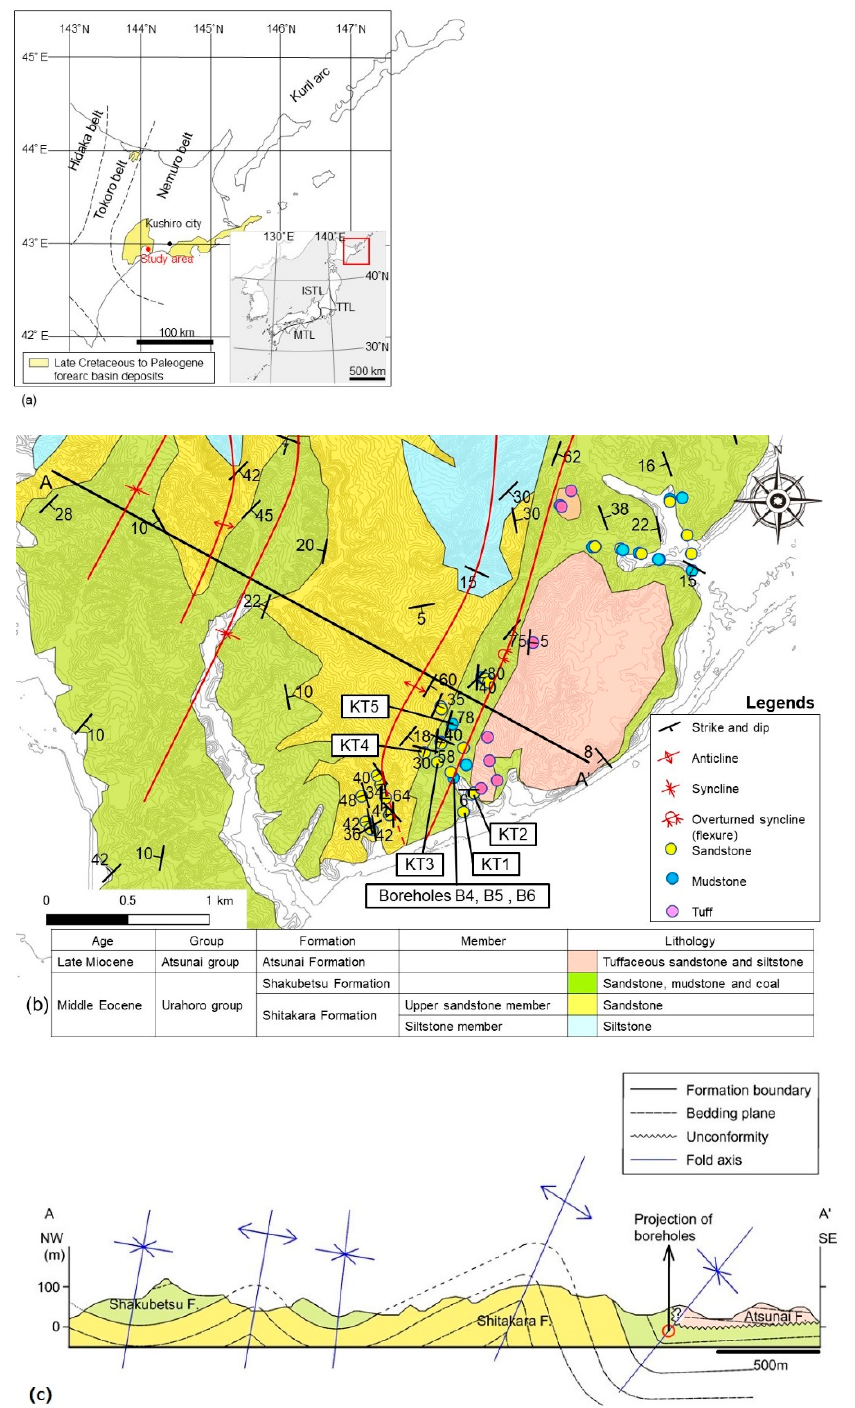
Figure 1. ( a ) Index map showing the Late Cretaceous and Paleogene forearc basin deposits in eastern Hokkaido, northern Japan, and the study area. The location of index map is shown by a red frame in the inset diagram. MTL, median tectonic line; ISTL, Itoigawa-Shizuoka tectonic line; TTL, Tanakura tectonic line. ( b ) Geological map modified after the previous literature [37], and results from our field survey are shown with circles (see legends). ( c ) Cross section; the traverse line for the cross section (A–A ′ ) is shown in ( b ).